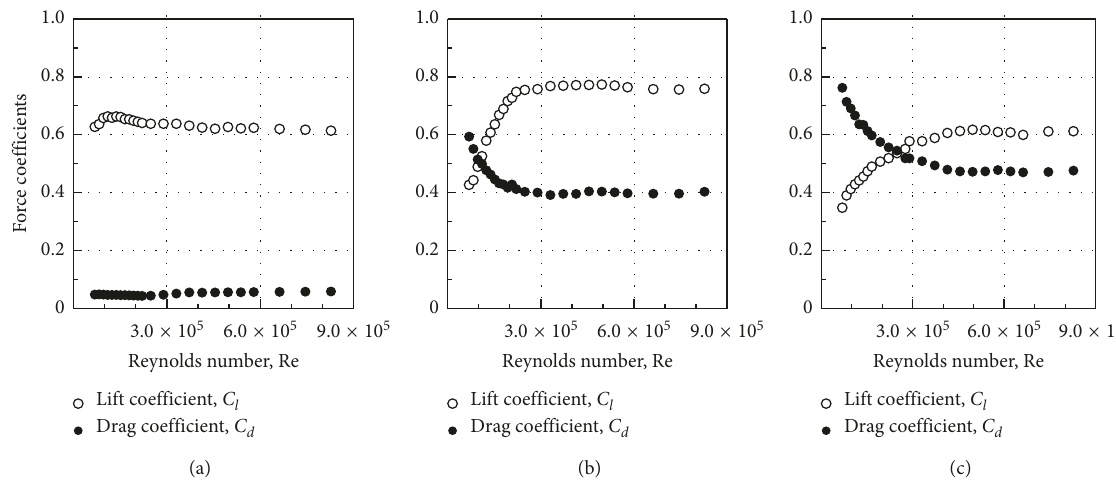
Figure 3: Variations of force coefficients with Reynolds number for cylindrical roofs with various rise-to-span ratios. (a) R / S � 1/6. (b) R / S � 1/3. (c) R / S �